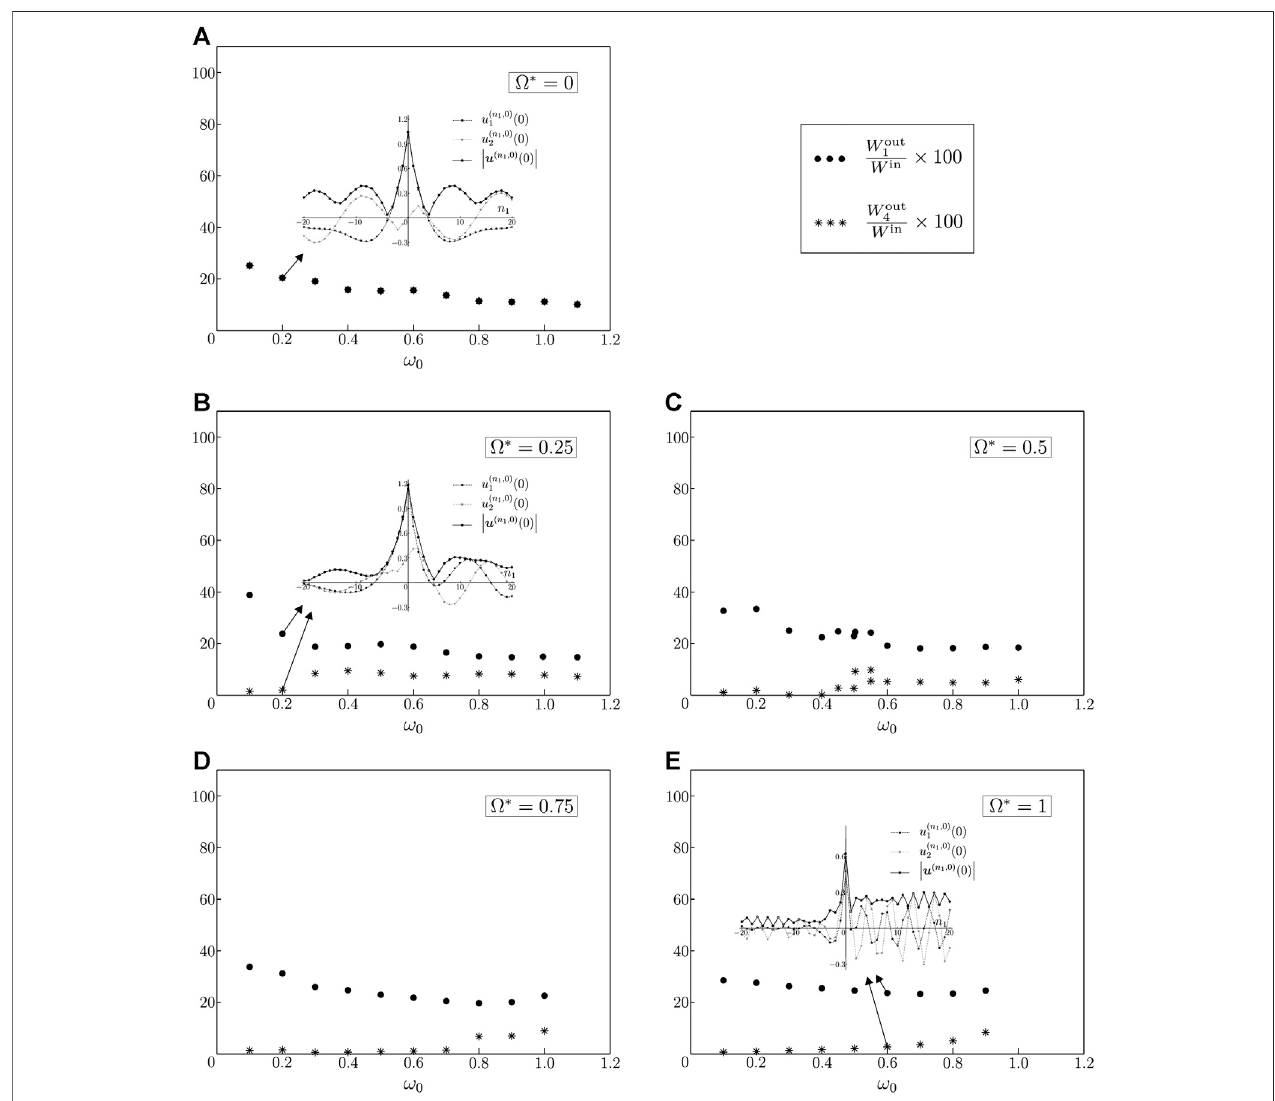
FIGURE 10 | Energy fl ow percentages associated with Rayleigh waves traveling to the right and to the left of the point force, indicated by W out 1 and W out 4 respectively,fordifferentvaluesofeffectivegyricityandfrequencyoftheexternalsource.Inthesecomputations,theforceactsinthehorizontaldirection.Theinsetsshow the displacements of the points on the lattice boundary, calculated at the frequencies indicated by the